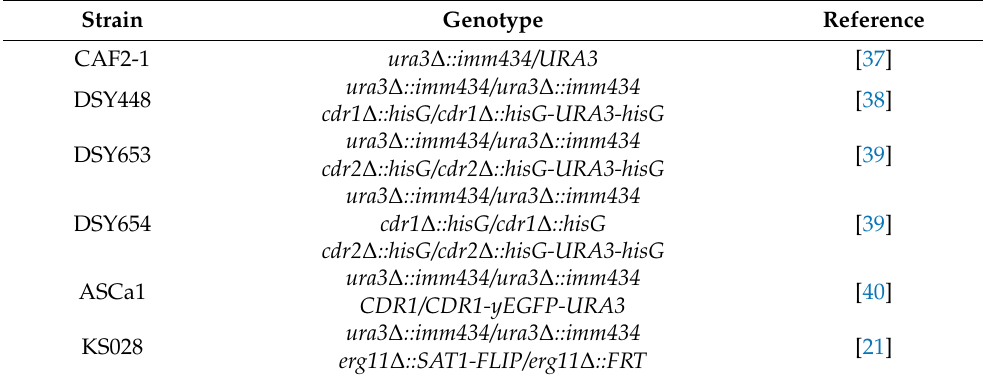
Table 3. C. albicans strains used in the